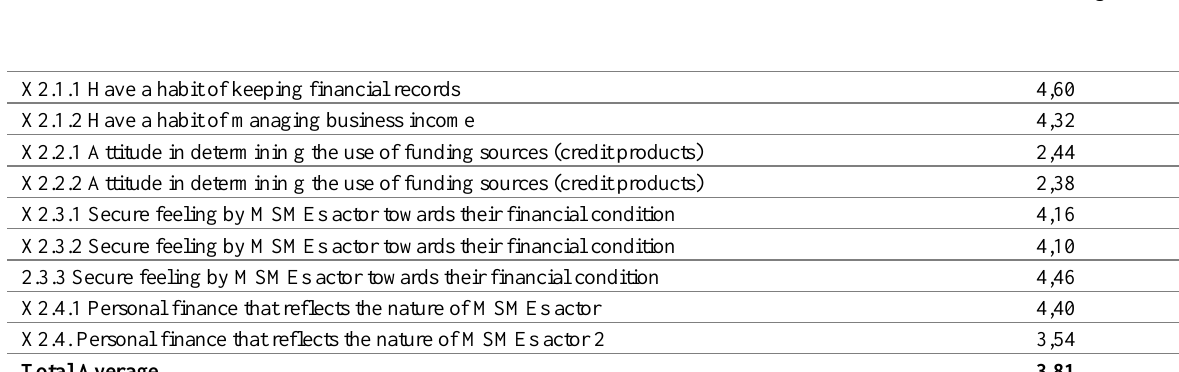
Table 3: Financial Attitude Variable Frequency